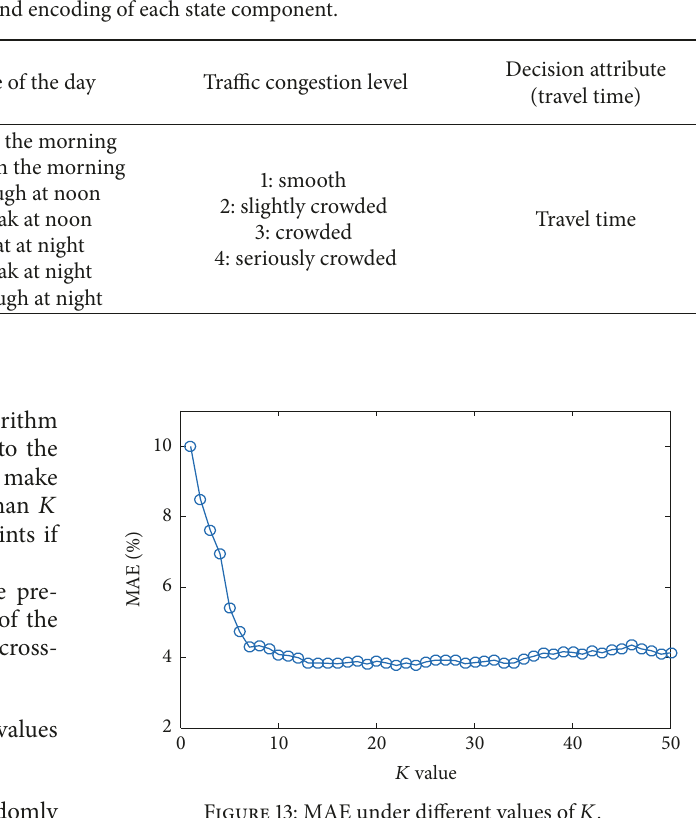
Figure 13: MAE under different values of 𝐾